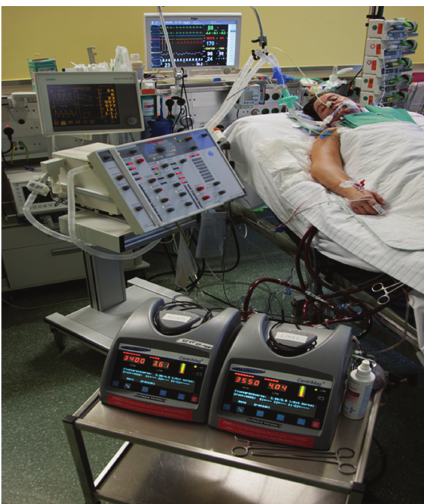
Figure 1: Patient on postoperative day 1. In front the two Centri- Mag pumps for biventricular